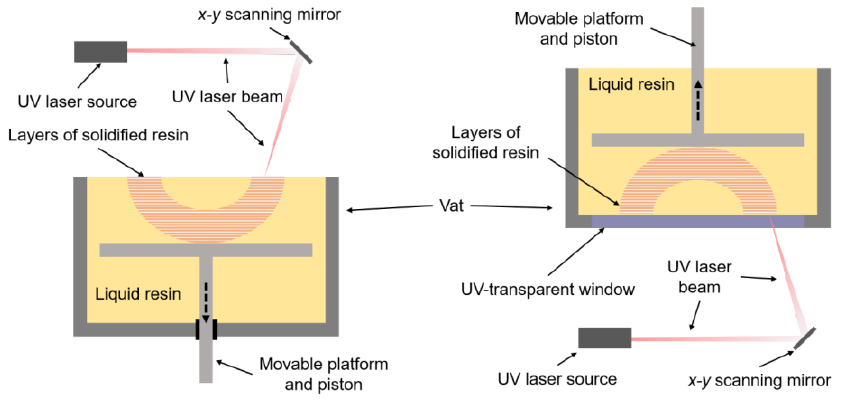
Figure 4. Schematic of a typical stereolithography printing method.